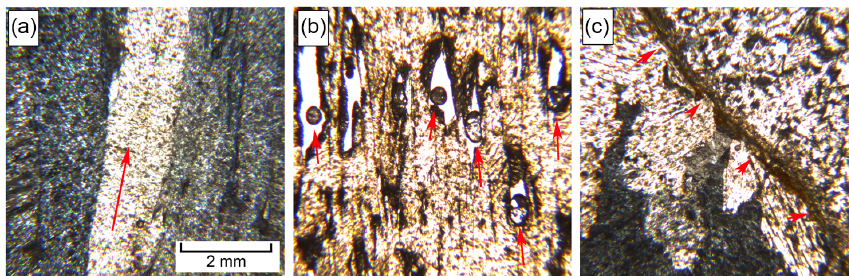
Figure 3. Thin section images of the Han-9. For locations, see Fig. 2d. All pictures are taken with crossed polarized light and have the same scale, and speleothem growth direction is upwards. (a) Thin section IIIB: (elongated) columnar calcite fabric. (b) IIIA: open columnar fabric, with fluid inclusions in the open voids. (c) IIA: discontinuity D2 is characterized by the presence of brown detrital material. Also note the different fabric underneath the hiatus.